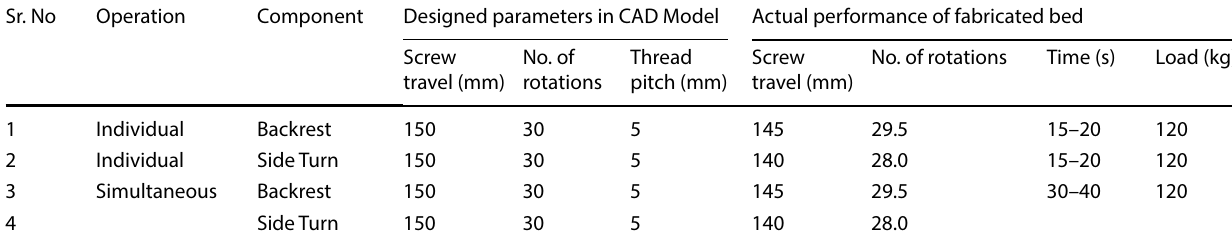
Table 1 Mechanical performance of the proposed bed Sr.